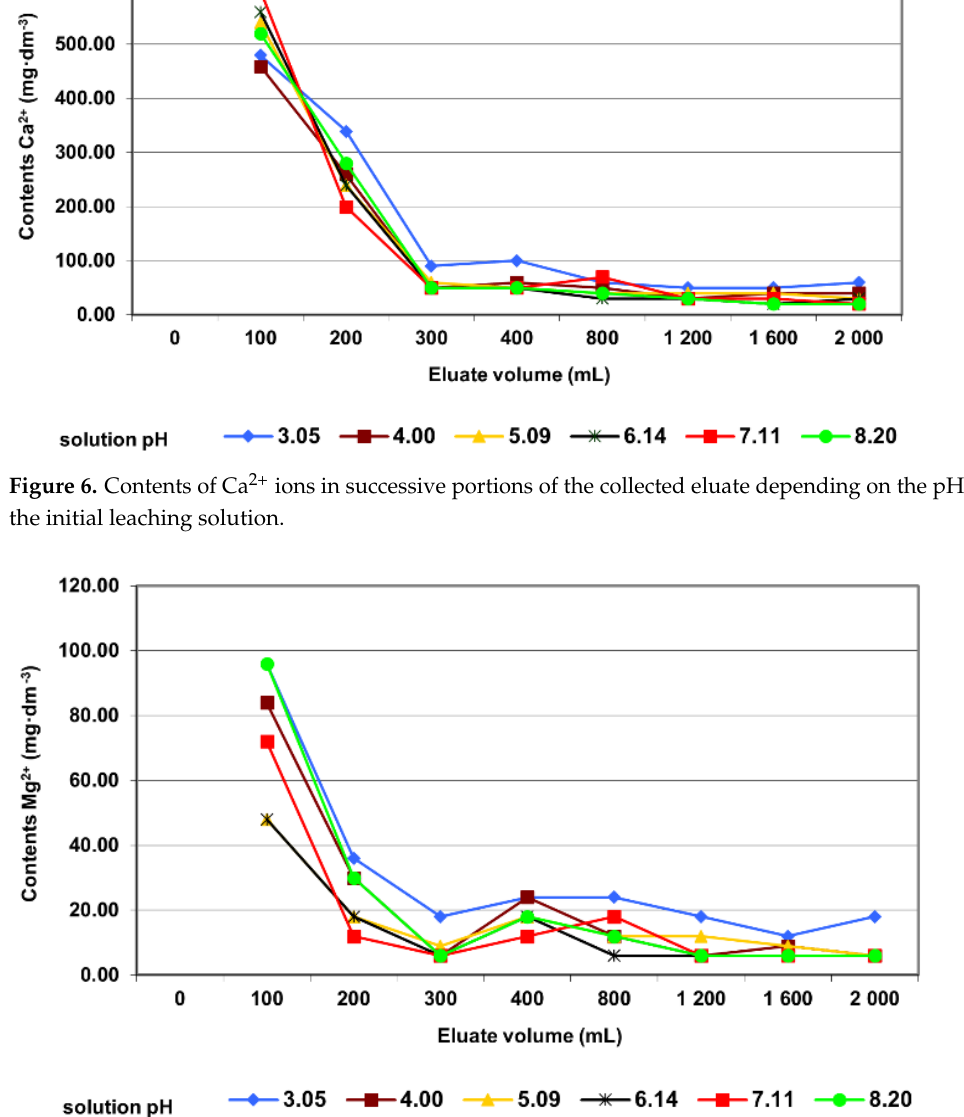
Figure 7. Contents of Mg 2+ ions in successive portions of the collected eluate depending on the pH of the initial leaching